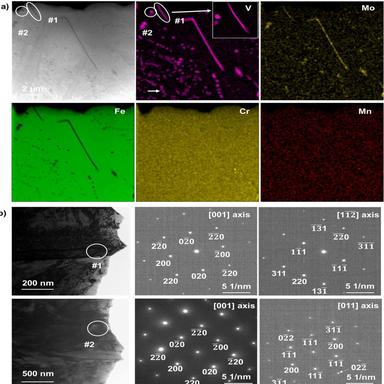
(a) EDS maps showing V-rich continuous (1) and discrete (2) carbides, (b) TEM images and SAED of continuous and discrete carbides confirming they have the same crystal symmetry despite different morphologies for as-sintered 85% binder saturated H13.